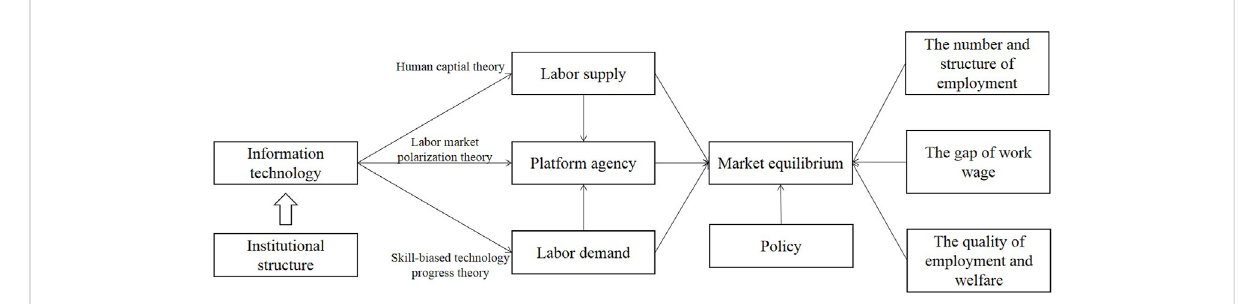
FIGURE 2 The impact of information technology development on labor supply and